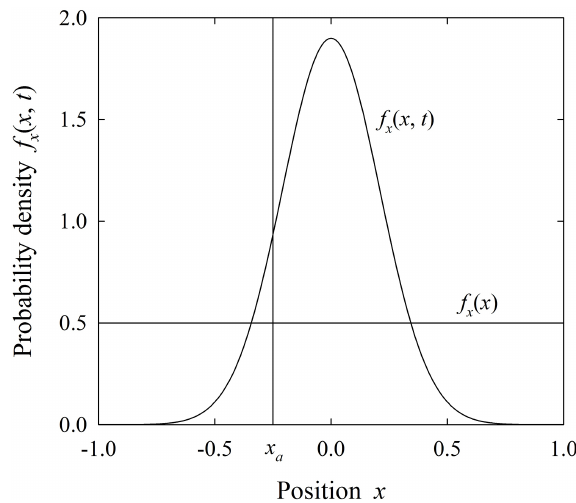
Figure A1. Plot of coordinate position x of particle undergoing a random-walk motion showing Gaussian distribution f x ( x,t ) of ex- pected positions at time t as the solution, Eq. (A2), of the Fokker– Planck equation, and the actual (example) particle position x = x a , and uniform steady-state distribution f x ( x ) = 1 / 2 for a bounded do- main such that − 1 < x <